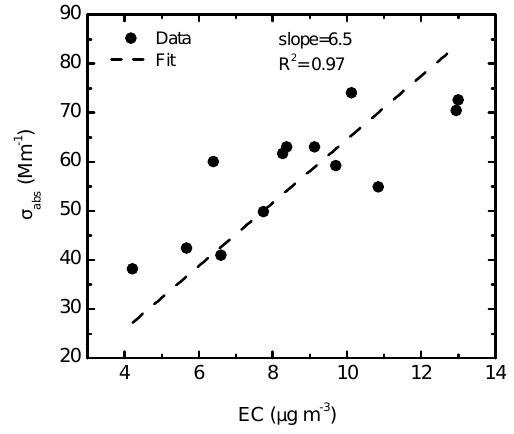
Fig. 9. Correlation between the light absorption measured by the MAAP and EC determined using the collected filters by means of a Sunset analyser (Sunset Laboratory